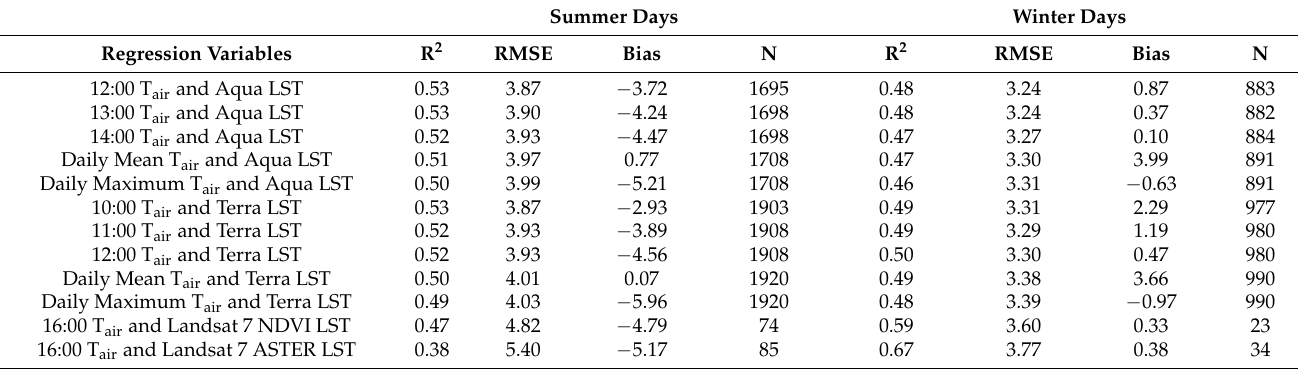
Table 6. Detailed results from regression analyses conducted using both MODIS satellites and Landsat 7 against air temperature based on forested in situ stations. All p -values are < 0.001.